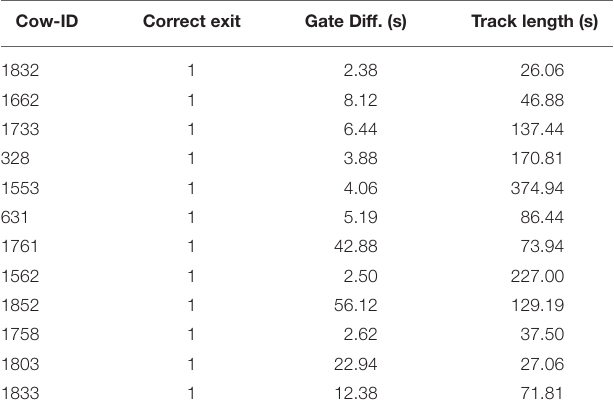
TABLE 1 | Complete trajectories of the simple sequence with columns indicating: cow id-number, tracker found the correct exit gate, time-difference between tracker exit and exit registered by the gate in seconds and the total length of the track in